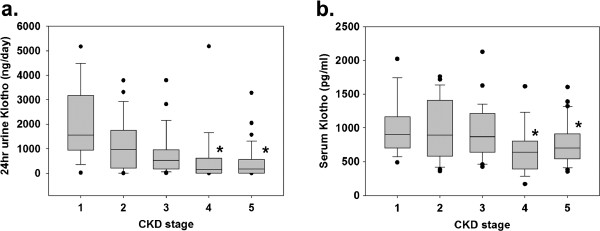
Box plots of the amount of 24 hr urinary excreted Klotho (a) and the serum Klotho levels (b) by CKD stages. The lower border of the box and the upper border of the box represent the first quartile and third quartile, respectively. The whiskers indicate 1.5 times the IR above and below the 25th and 75th percentiles. Outliers (values >1.5 times the IR) are represented by closed circles. *p < 0.05 vs CKD stage I.